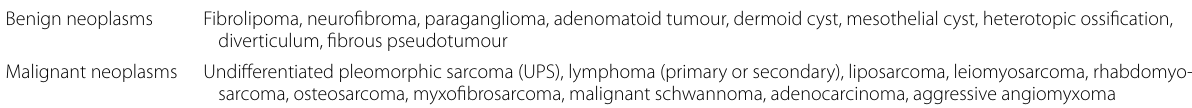
Table 4 Spermatic cord neoplasms [30–33] Benign